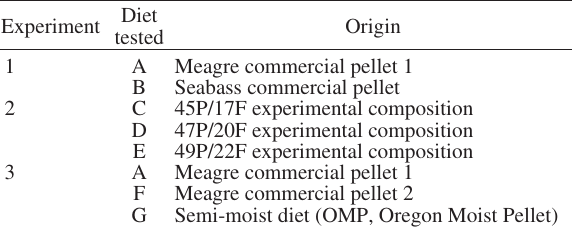
Table 1. – Tested diets.